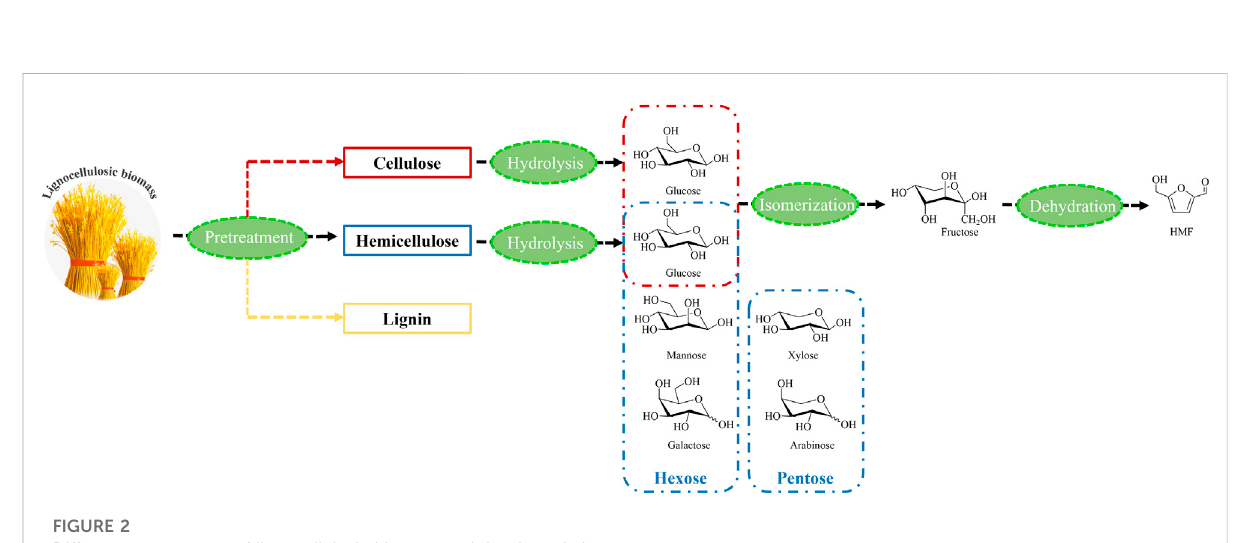
FIGURE 2 Different components of lignocellulosic biomass and the